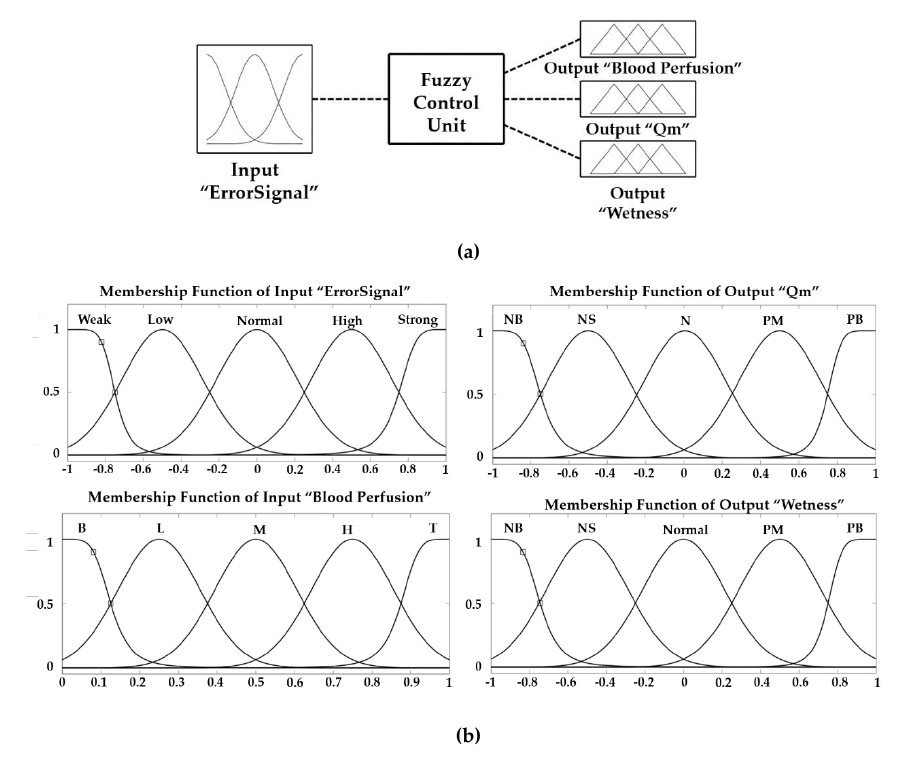
Figure 1. ( a ) The structure of fuzzy control model; ( b ) membership functions of fuzzy control model.